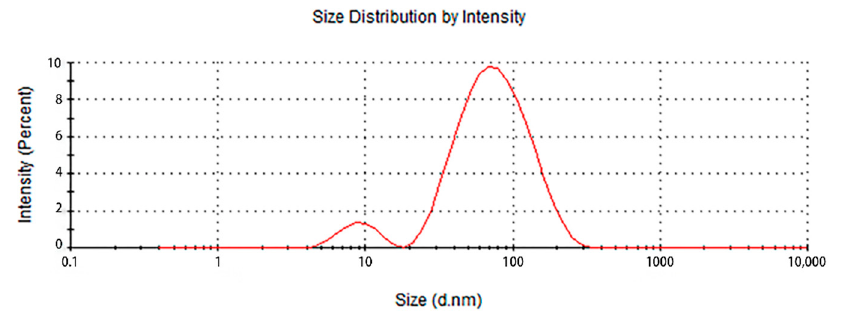
Figure 4. Particle size distribution of the GL-reduced AgNPs.